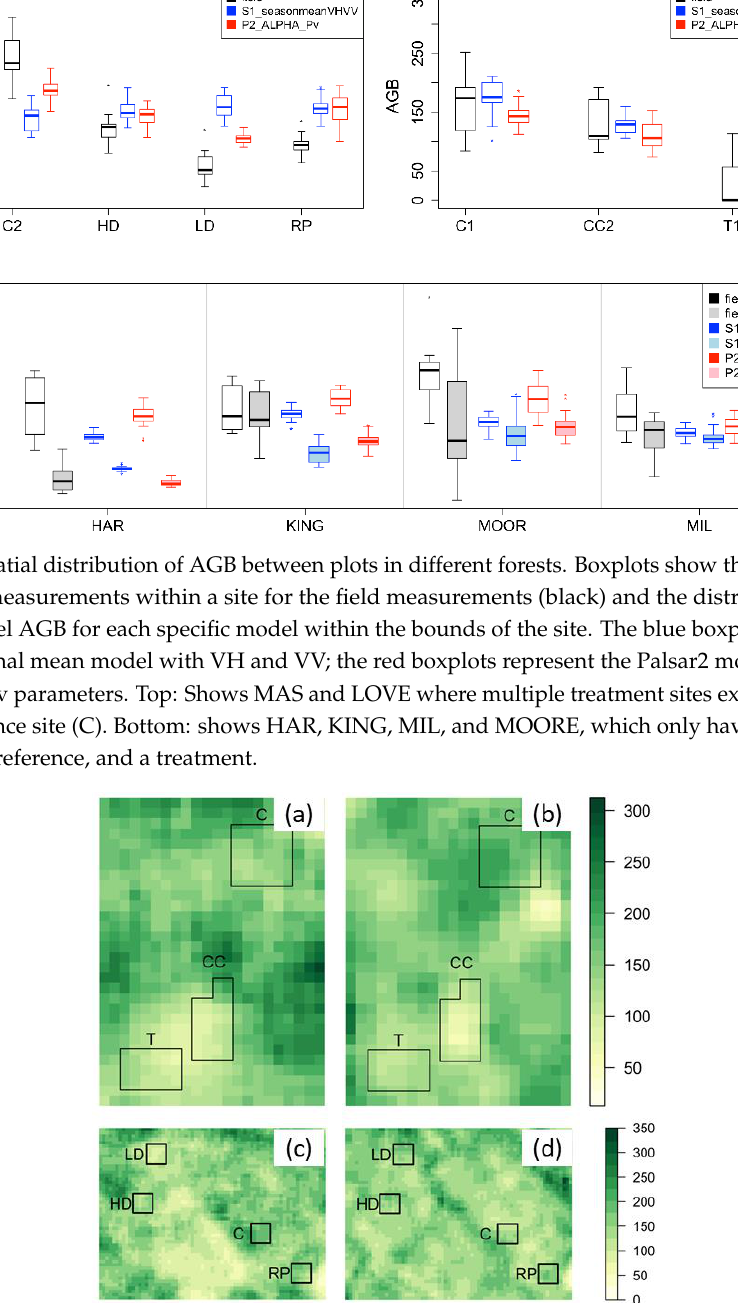
Figure 9. AGB maps over LOVE and MAS forests using best models from S1 and P2 corresponding to top figure in Figure 8. ( a ) S1 in LOVE forest. ( b ) P2 in LOVE forest. ( c ) S1 in MAS forest. ( d ) P2 in MAS forest. The black boxes are the boundaries of the sites. P2 model is more consistent than the S1 model at following trend between sites at MAS while the S1 model appears a better fit to the relative differences between LOVE sites.